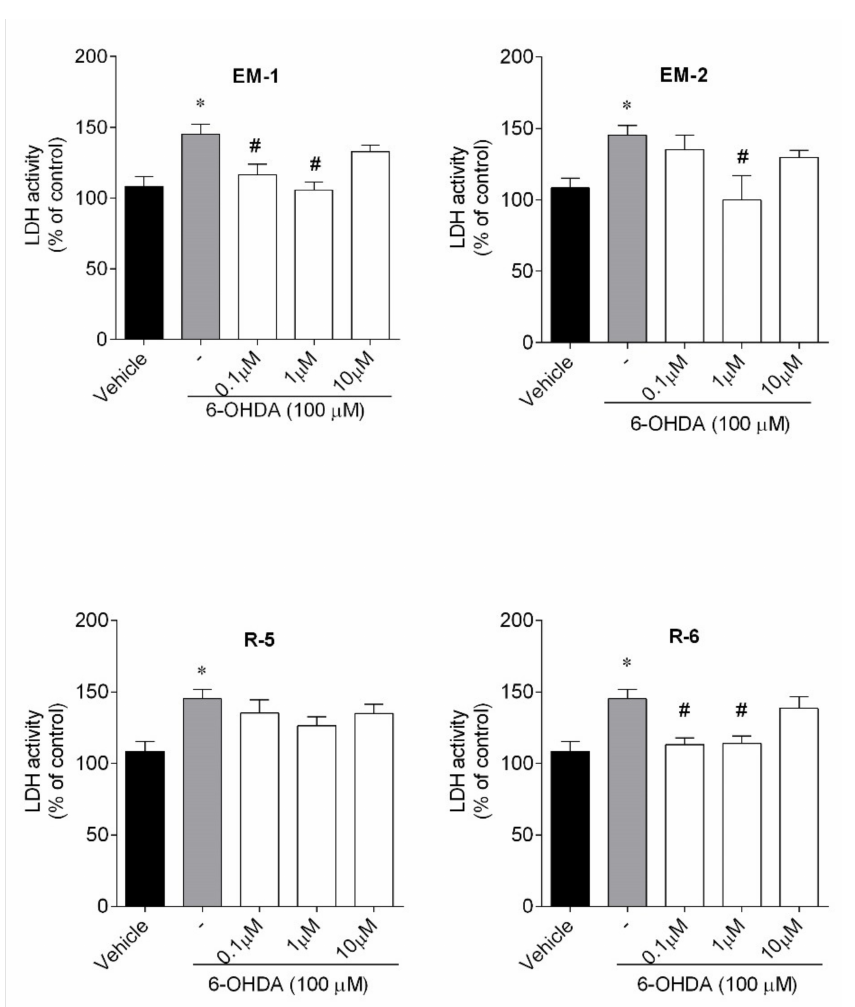
Figure 5. Effect of peptides (0.1–10 µ M, 24 h) on LDH activity in 6-OHDA-treated (100 µ M) SH-SY5Y cells. The values in each column represent the mean ± SEM of 4 independent experiments. Symbols represent significant differences (ANOVA, Dunnett’s test, p < 0.05) when compared to: * vehicle and # 6-OHDA. (-)